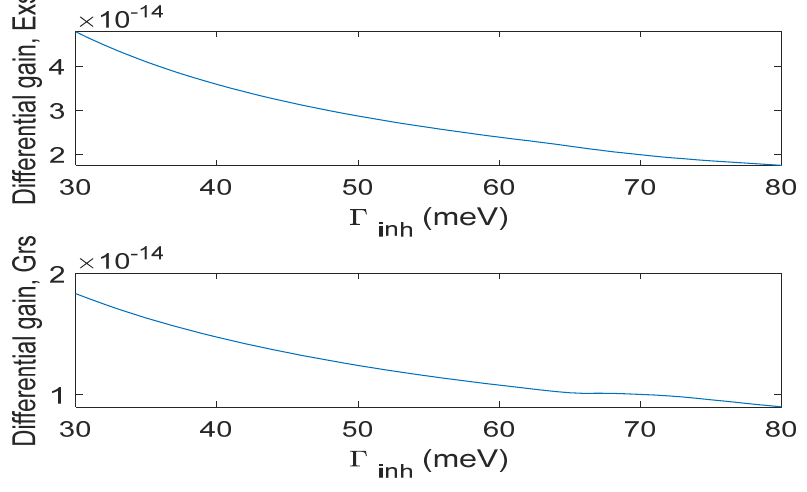
Figure 4. Variation of differential gain as a function of the Γ ihom for I rf = 40 mA.